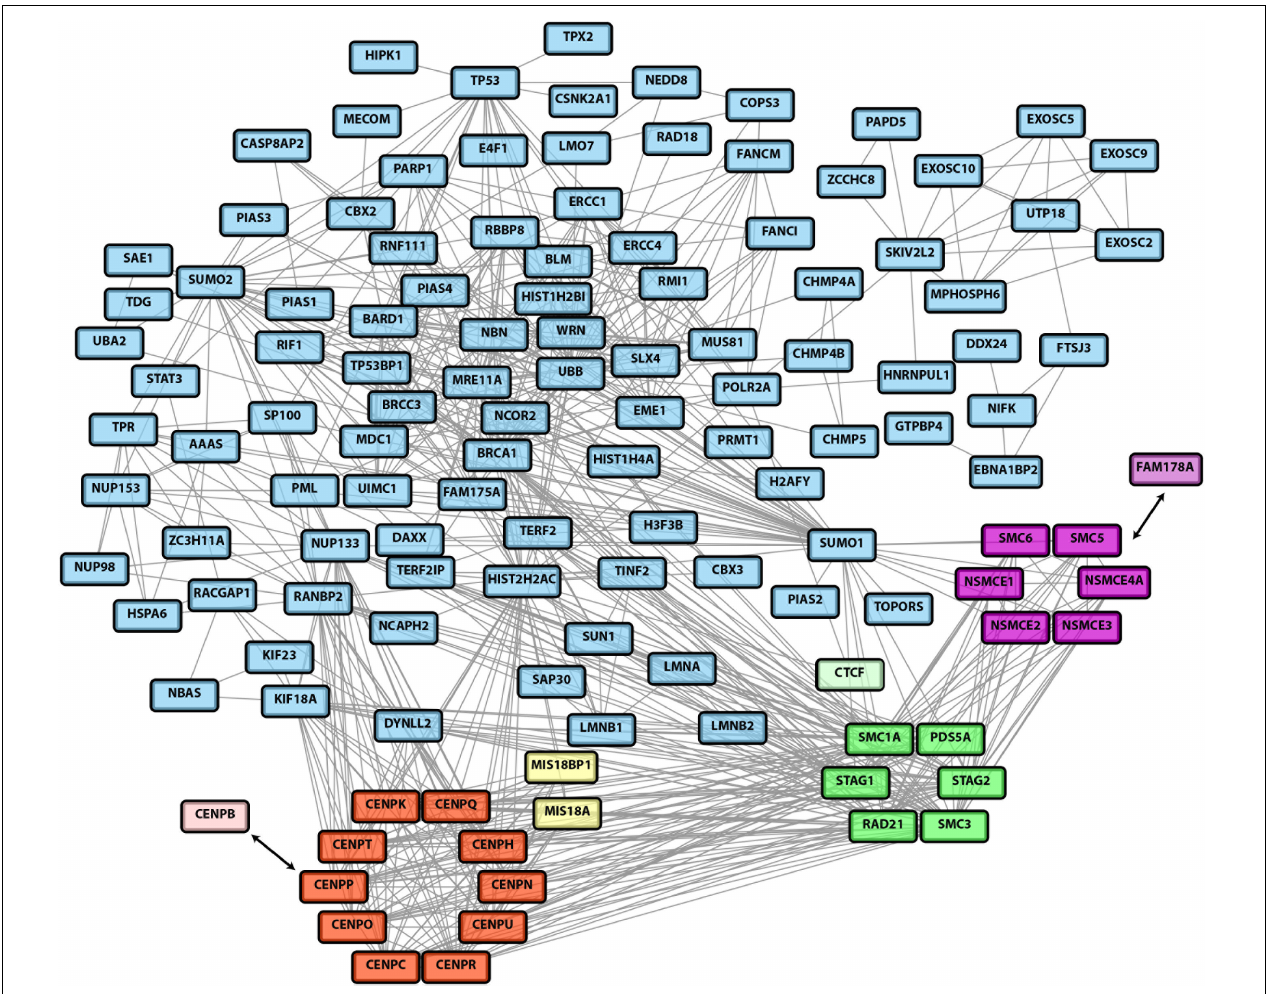
FIGURE 1 | A network of SENP6 targets identified by two recent unbiased proteomic studies (Liebelt et al., 2019; Wagner et al., 2019). Candidate SENP6 targets identified in both studies were combined into a single dataset. This dataset was then used for the generation of a network using the STRING database (version 11.0, https://string-db.org). Only highest confidence interactions (interaction score > 0.9) were considered. Experiments and databases were used as interaction sources. Disconnected nodes were removed from the network. The network data was imported into Cytoscape. The core components of the constitutive centromere associated network (CCAN) are highlighted as red subcluster. The associated CENP-B and the CENP-A targeting factors Mis18A/Mis18BP1 are depicted in light red and yellow, respectively. The cohesion complex is represented by the green subcluster (with the CTCF targeting factor in light green) and the SMC5/6 complex is highlighted in magenta. The SMC5/6 recruitment factor FAM178A/Slf2 is shown in